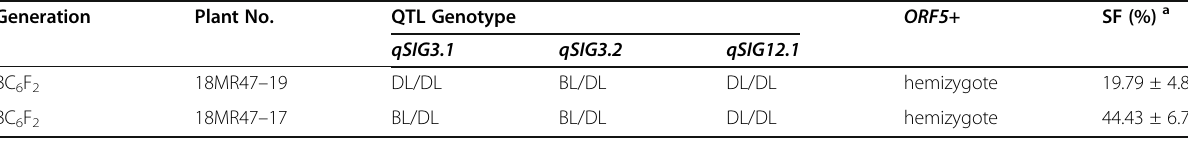
Table 3 Genotype and SF of plants 18MR47 – 19 and 18MR47 – 17 Generation